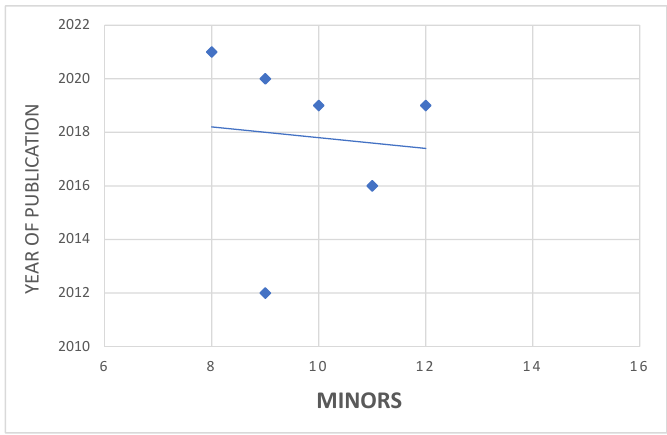
Figure 2. MINORS association with time of publication.